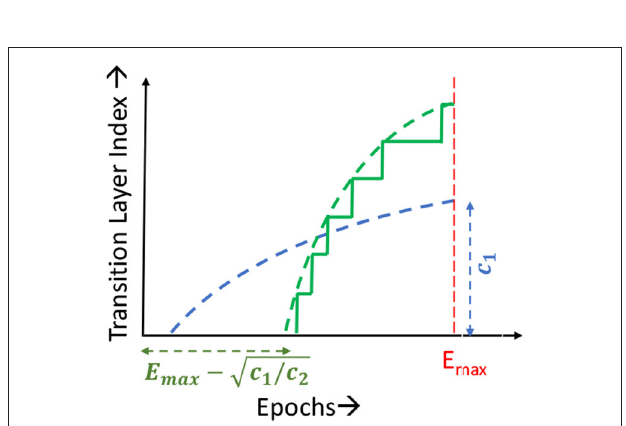
FIGURE 3 | Transition layer schedules.